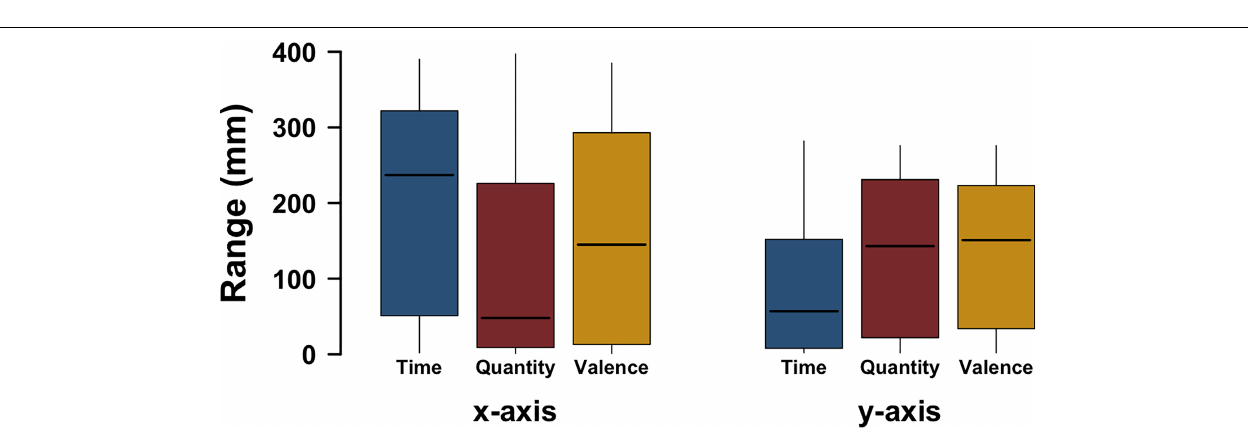
FIGURE 2 | Experiment 2: Dominant Orientation (horizontal, vertical, diagonal) as a function of Task; r indicates adjusted standardized Pearson residuals, which are based on the pooled data (participants contribute multiple data points), and H indicates Shannon entropy scores.